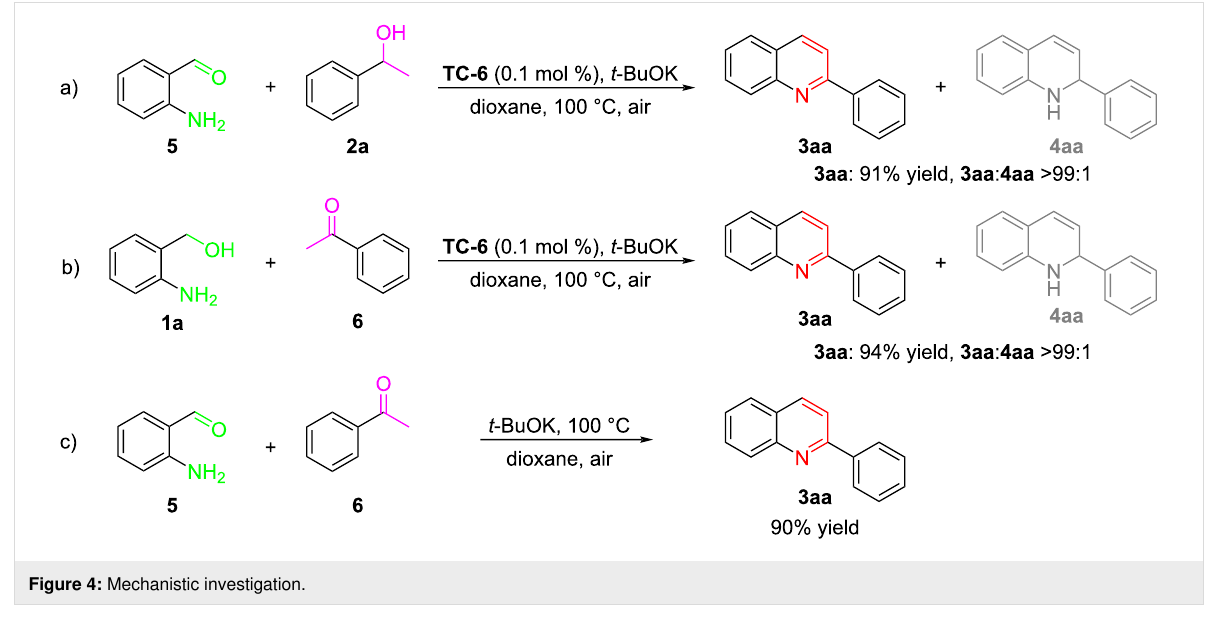
Figure 4: Mechanistic investigation.